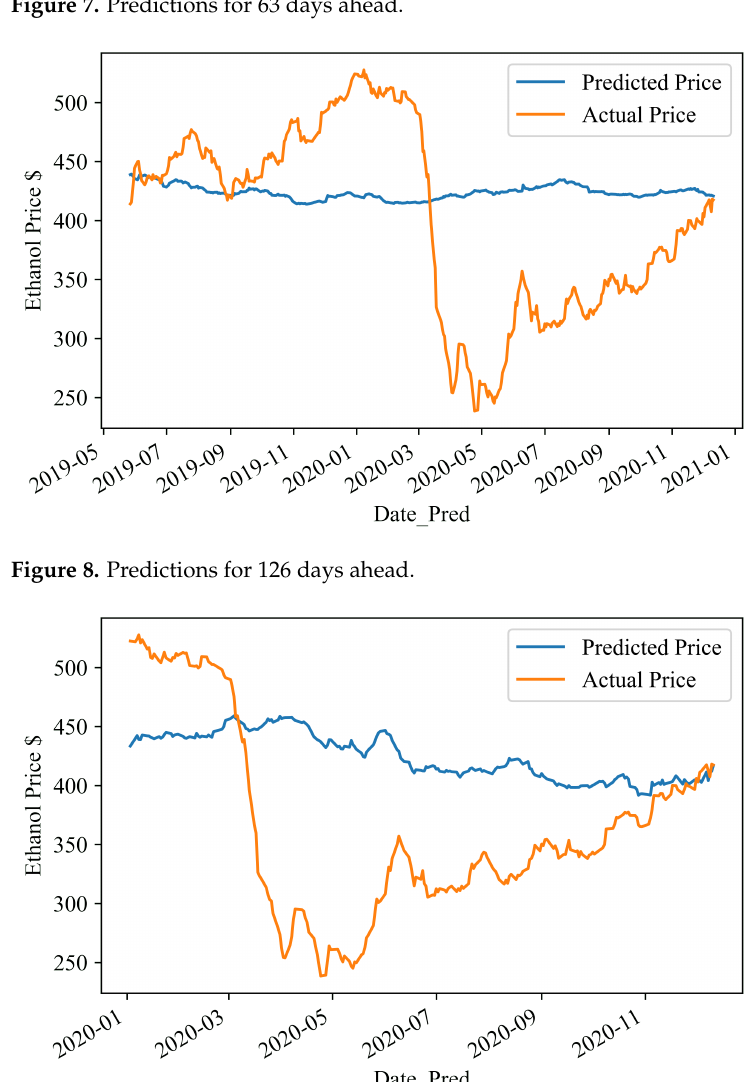
Figure 7. Predictions for 63 days ahead.